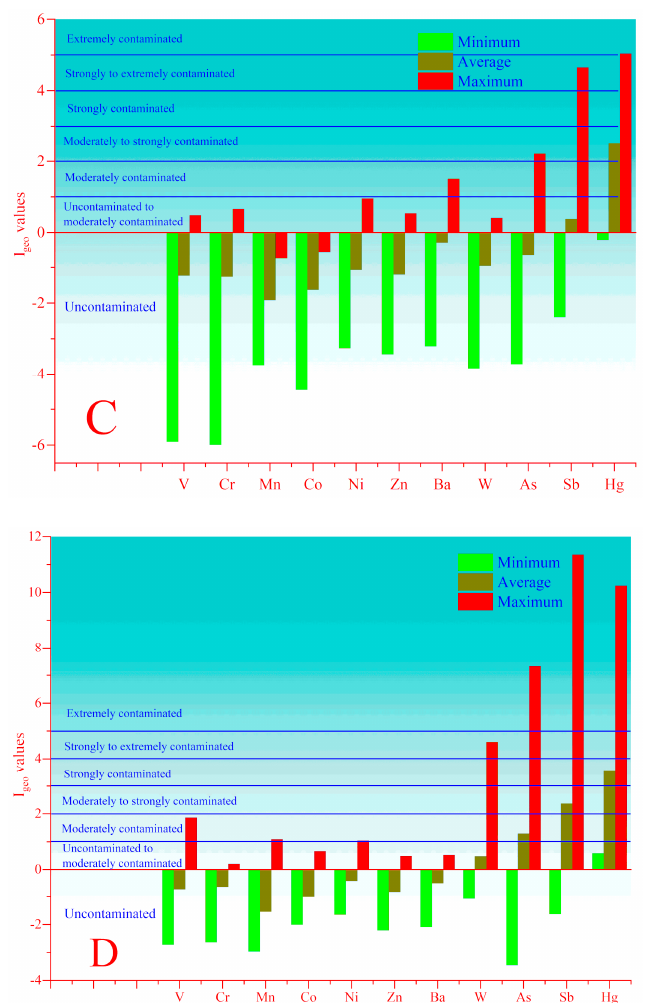
Figure 7. Values of Igeo for unexposed ( A ) and exposed to anthropogenic impact soils ( B ); as well as unexposed ( C ) and exposed to anthropogenic impact sediments ( D ).